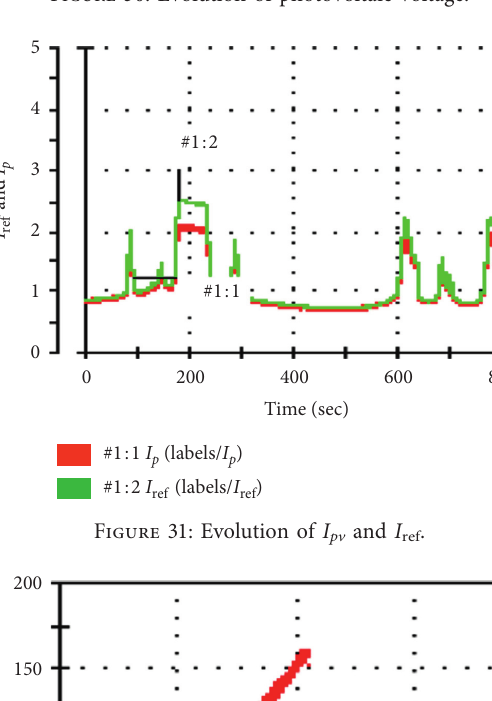
Figure 30: Evolution of photovoltaic voltage.